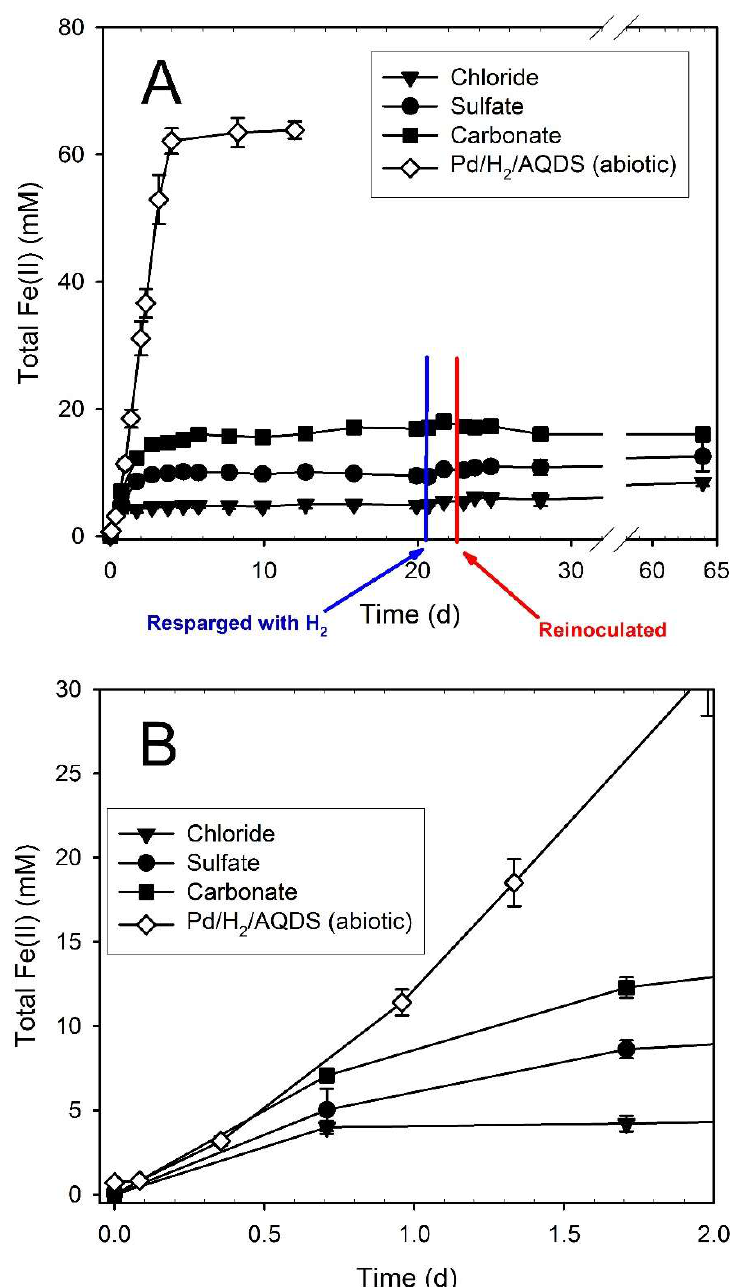
Figure 2. ( A ) Fe(II) production during the bioreduction of lepidocrocite by S. putrefaciens CN32 using H 2 as an electron donor in the presence of either chloride, sulfate, or carbonate, compared to abiotic reduction of lepidocrocite by H 2 in the presence of Pd catalyst, the electron shuttle 9,10-anthraquinone 2,6 disulfonate (AQDS), and carbonate and ( B ) an expanded view of Fe(II) production within the first 2 days. Error bars indicate one standard deviation.